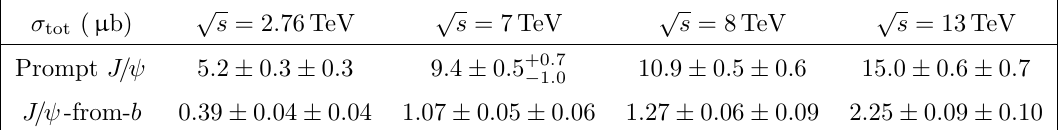
Table 5 . Production cross-sections of prompt J= and J= -from- b mesons, integrated over the LHCb (cid:12)ducial region, in pp collisions at various centre-of-mass energies. The (cid:12)rst uncertainty is the uncorrelated component, and the second the correlated one.